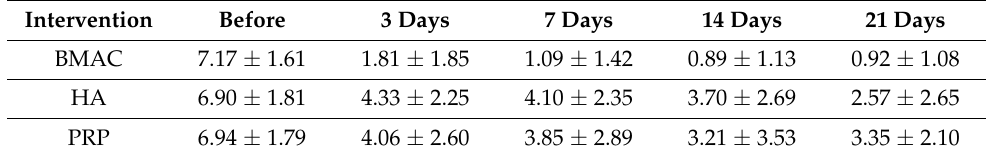
Table 2. Values of knee VAS scores in groups over time.